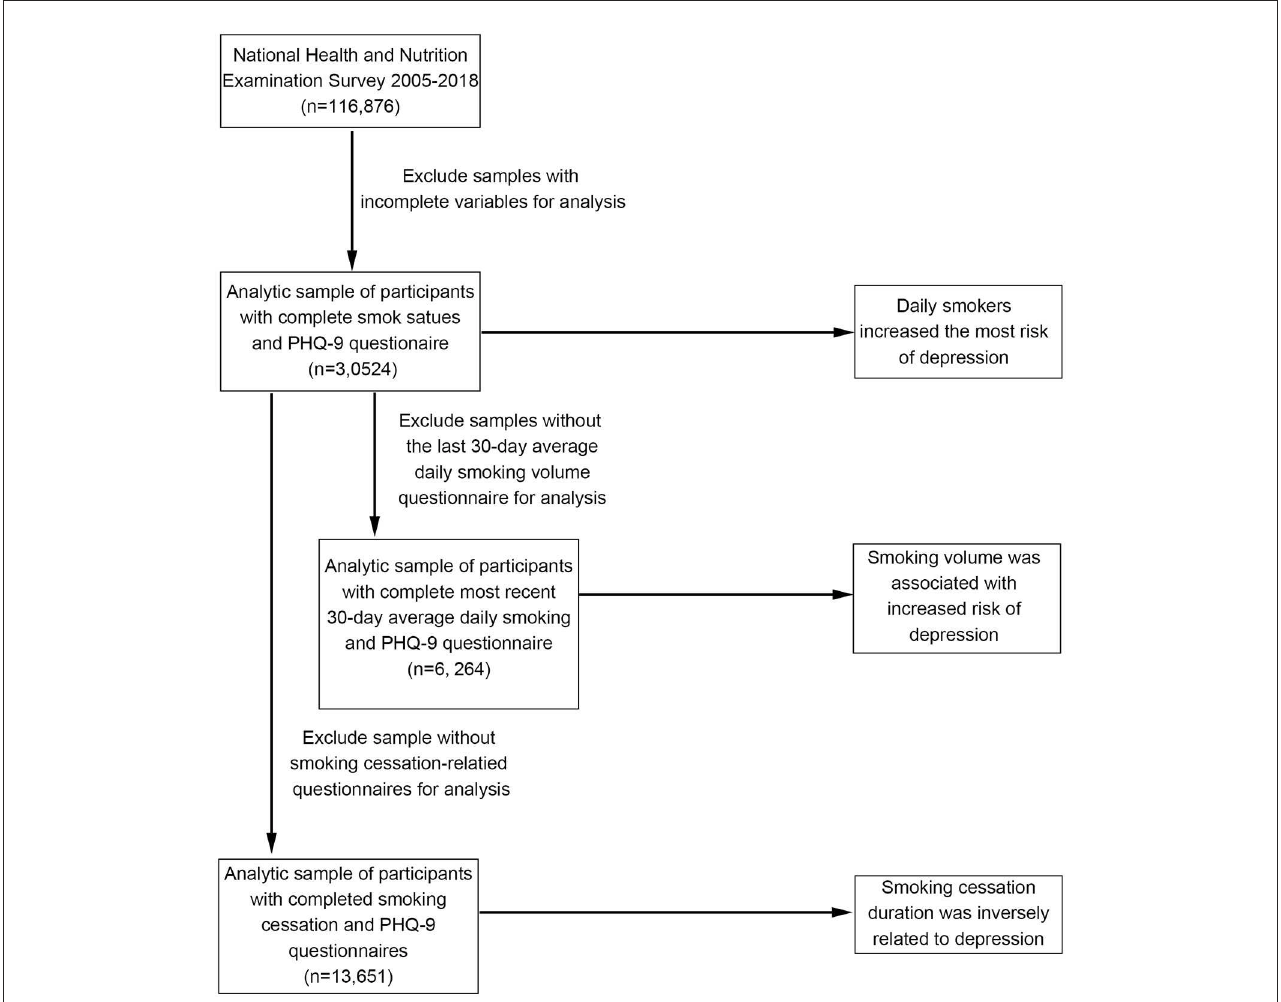
FIGURE1 Flowchart of the sample selection from NHANES